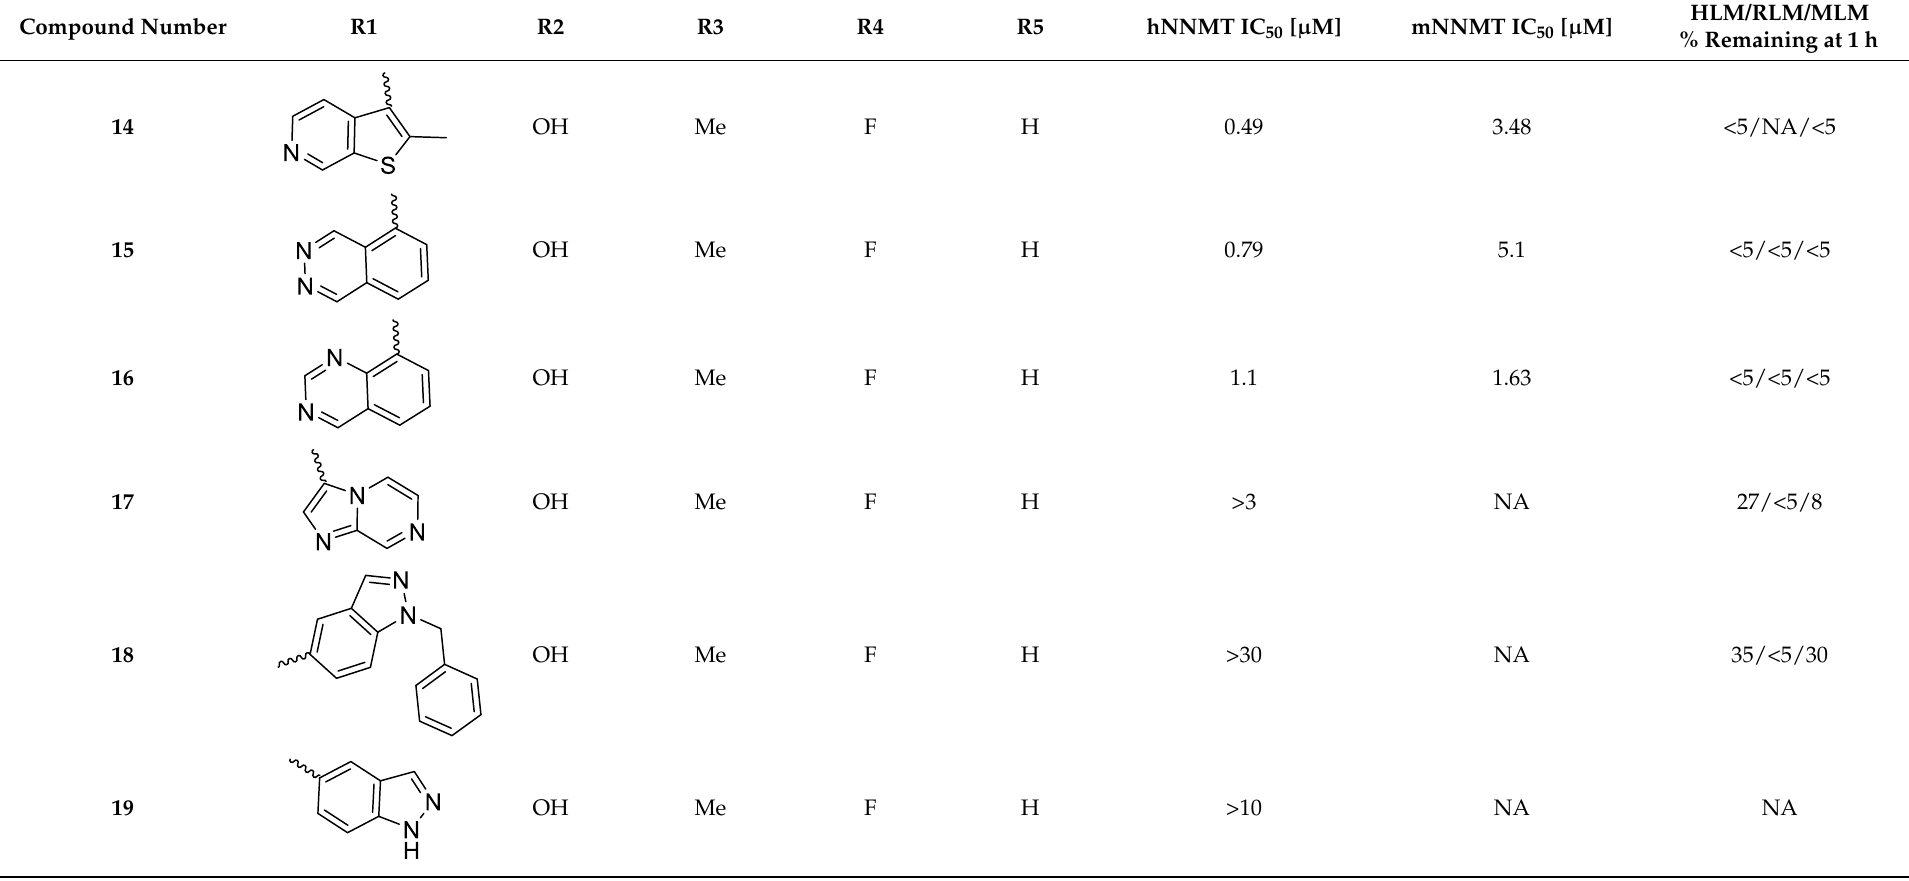
Table 2. Overview of NNMT inhibitors ( 14 )–( 24 ) and human/rat/mouse liver microsome (HLM/RLM/MLM) data Compound Number